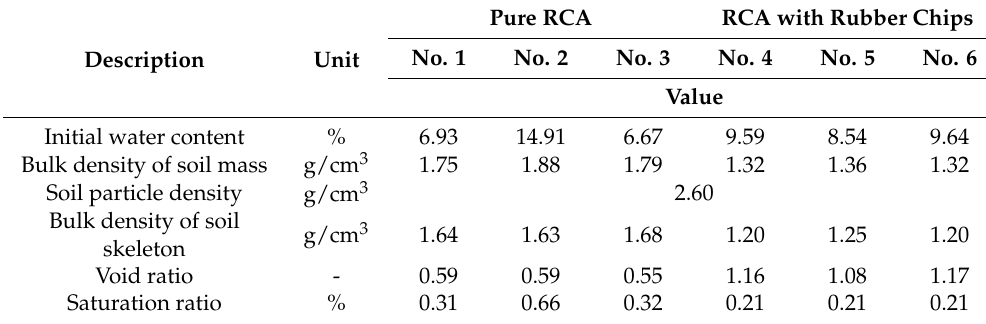
Table 2. Initial properties of pure RCA specimens and mixtures of RCA with rubber